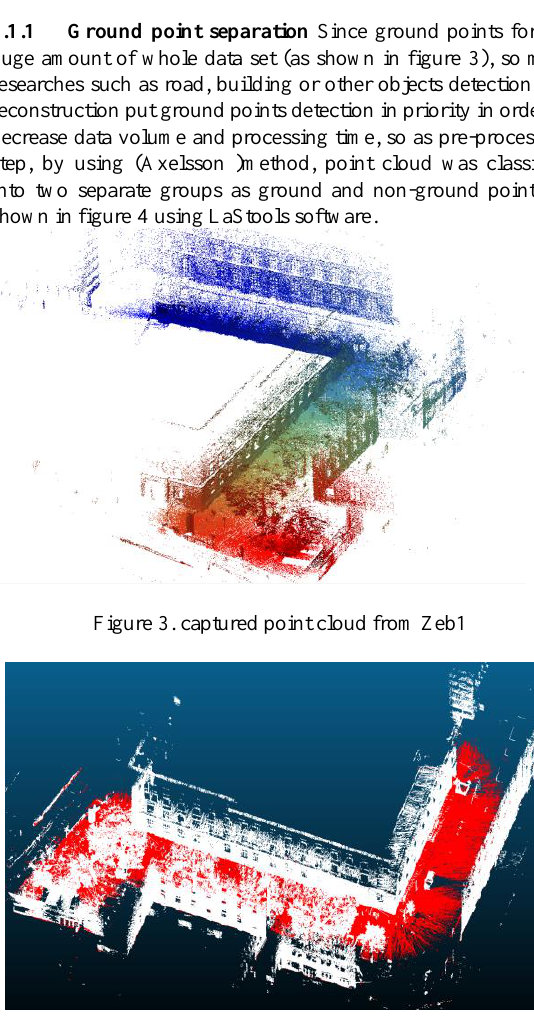
Figure 4. ground and non-ground points which are separated in white and red colors respectively